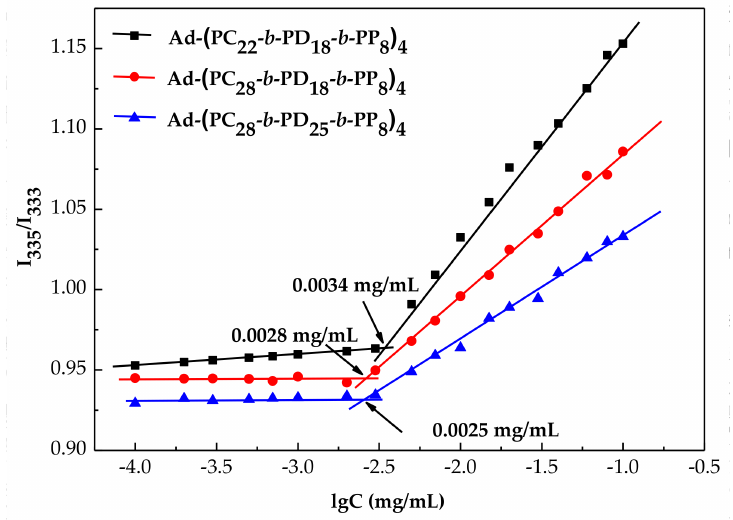
Figure 3. Graphs of intensity ratios ( I 335 / I 333 ) as function of logarithm of polymeric concentrations in aqueous solution.